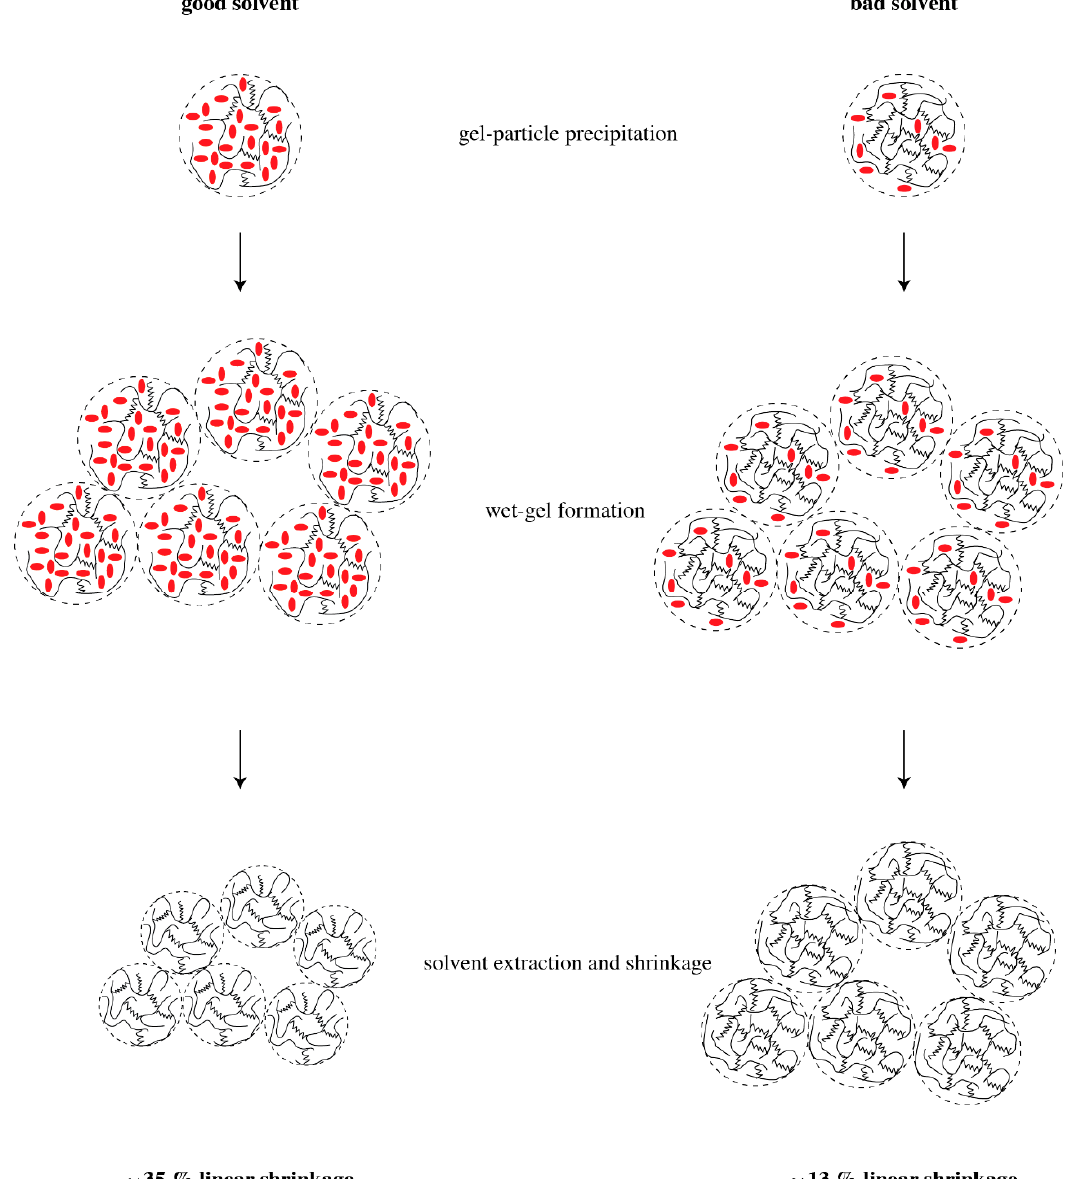
Figure 6. Illustration of microgel particle formation and shrinkage for PMHS/DVB polymer aerogel formation in a “good” solvent such as cyclohexane ( left ) and a “bad” solvent such as acetone ( right ). Solvent molecules are depicted in red; polymer strands are shown as black lines.